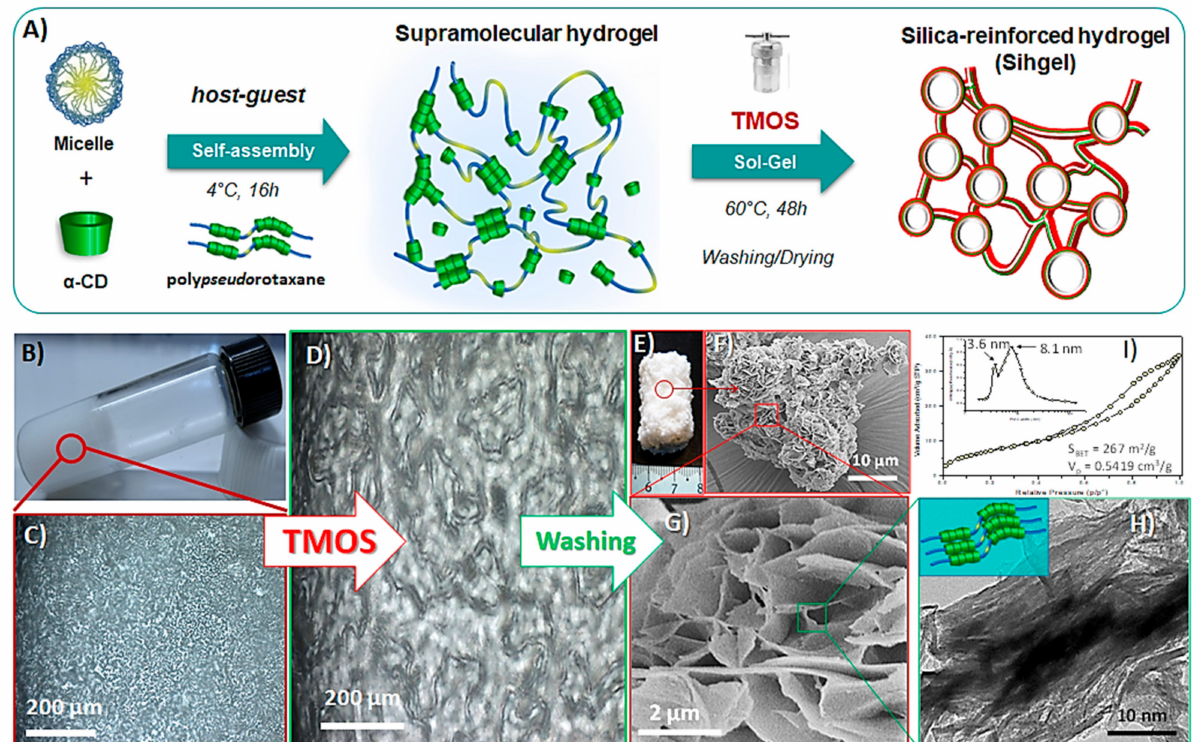
Figure 1. Schematic illustration of the procedure used for the preparation of silica-reinforced Pluronic F127/ α CD hydrogel ( A ). Visual aspect of the supramolecular hydrogel ( B ). Polarized optical mi- croscopy images of the hydrogel before ( C ) and after silicification ( D ) showing birefringent textures. Visual aspect of the porous monolith after annealing at 60 ◦ C and removal of the excess of template ( E ). SEM ( F , G ) and TEM ( H ) micrographs of the silicified hydrogel and corresponding N 2 adsorption results ( I